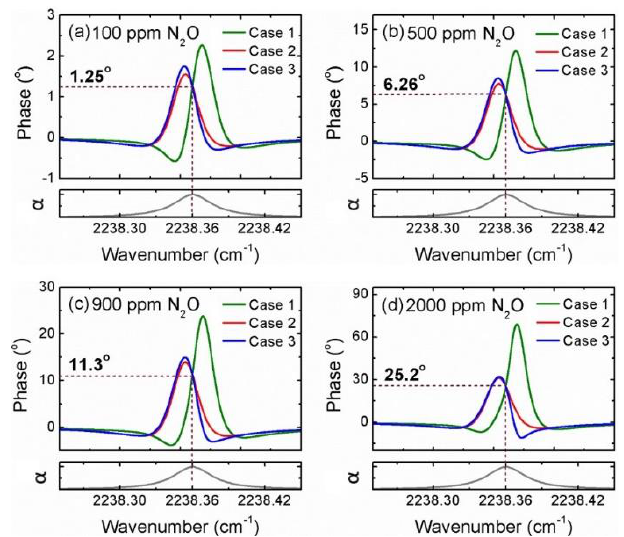
Figure 6. Calculated HPSDS spectra of N 2 O at ( a ) 100 ppm, ( b ) 500 ppm, ( c ) 900 ppm, and ( d ) 2000 ppm, for three different combinations of laser parameters β , m , and θ . Case 1: β = 0.004, m = 0.002, θ = 0.71π; case 2: β = 0.001, m = 0.002, θ = 0; and case 3: β = 0.0025, m = 0.002, θ = 0.31π.